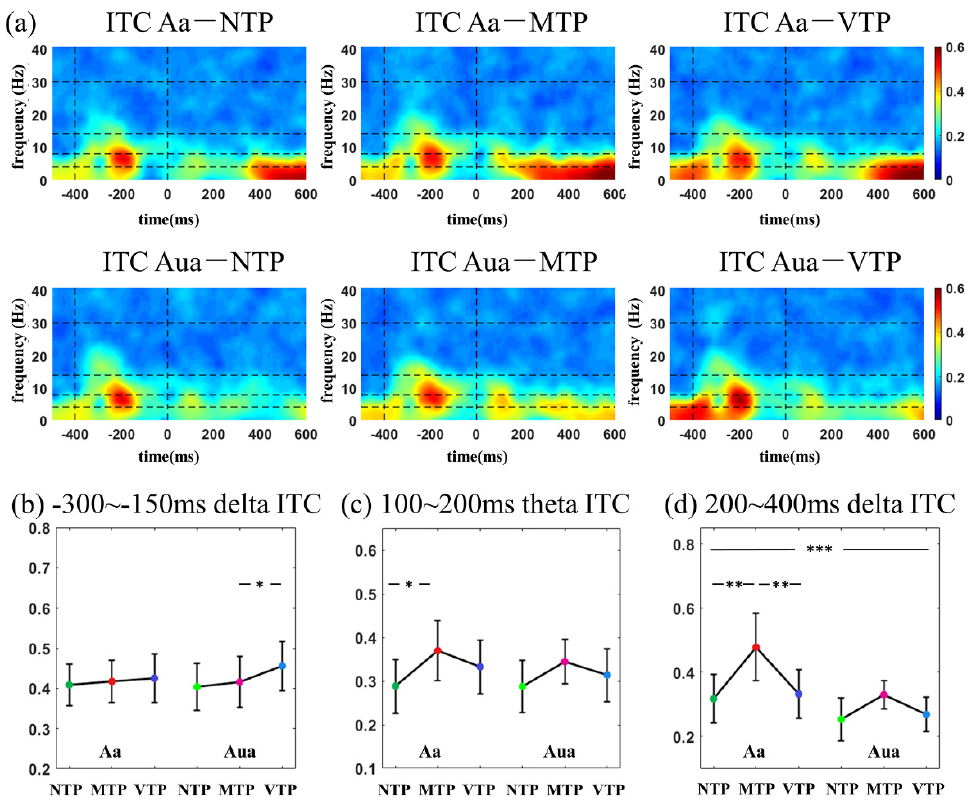
Figure 6. ( a ) ITC time–frequency distributions in auditory modality; comparisons among